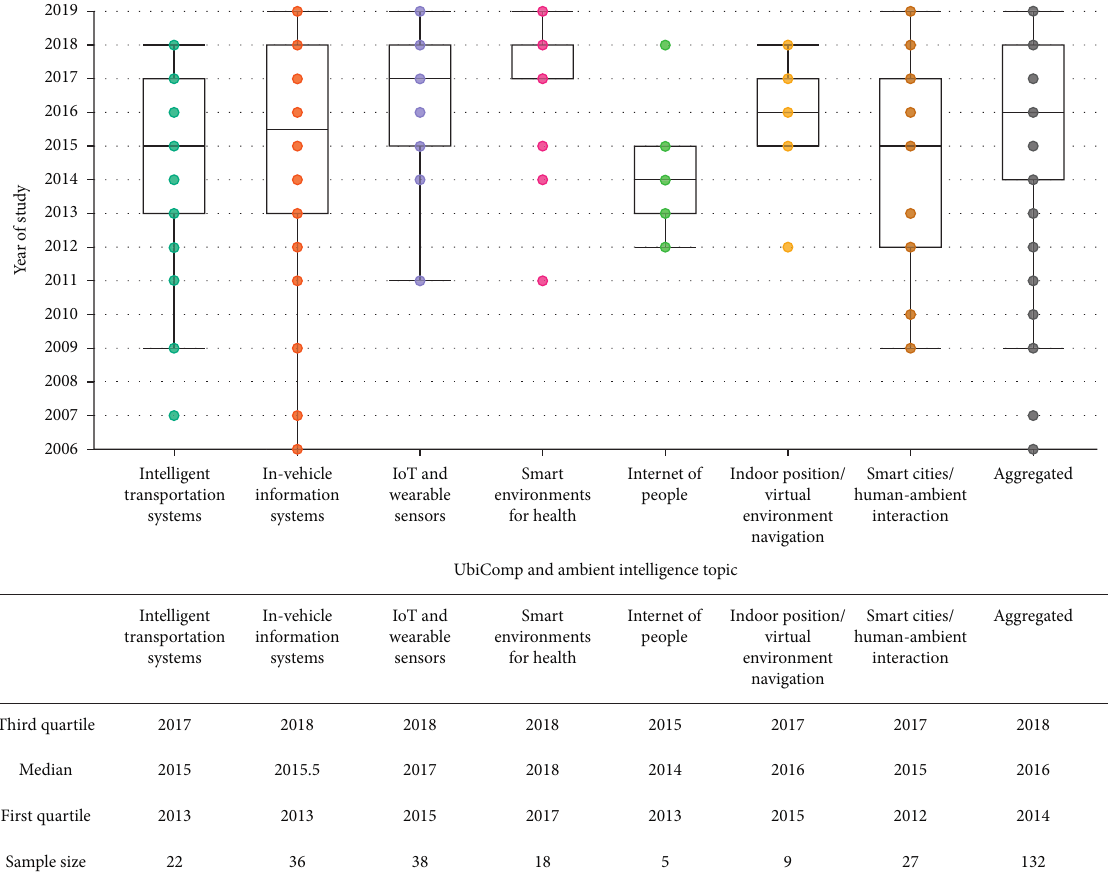
Figure 12: Ubiquitous computing and ambient intelligence studies evaluated with standardized questionnaires by year.